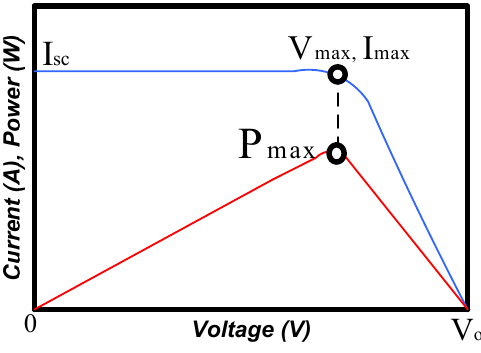
Figure 3. PV module characteristic curves (I–V) and (P–V).